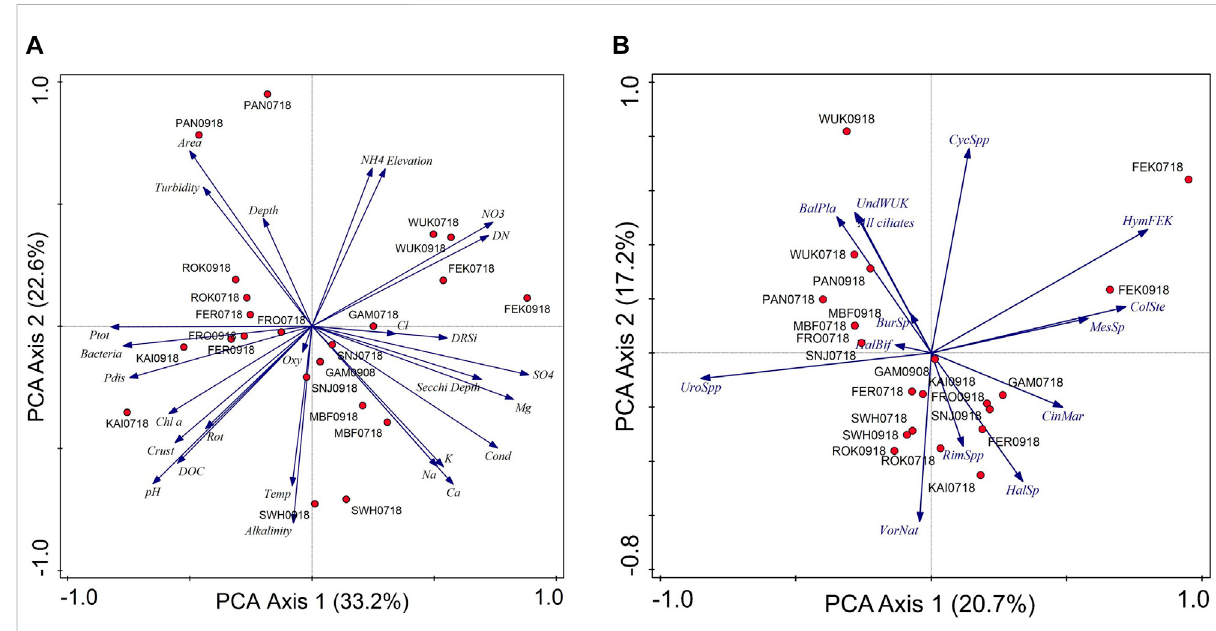
FIGURE 4 Principal component analyzes (PCA) of (A) the abiotic/environmental parameters, and (B) the ciliate communities (based on abundance data; > 1%oftotalmeanabundanceinmorethanonesample)forthe11mountainreservoirs.PercentagesindicateamountexplainedbytheindividualPCA axes. Cond, conductivity; Crust, crustaceans; Rot, rotifers; Ptot, total phosphorus; Pdis, dissolved phosphorus; Temp, temperature; BalPla, Balanion planctonicum , BurSp., Bursaridium sp., CinMar., Cinetochilum margaritaceum , ColSte, Colpoda steinii , CycSp, Cyclidium spp., HalBif,